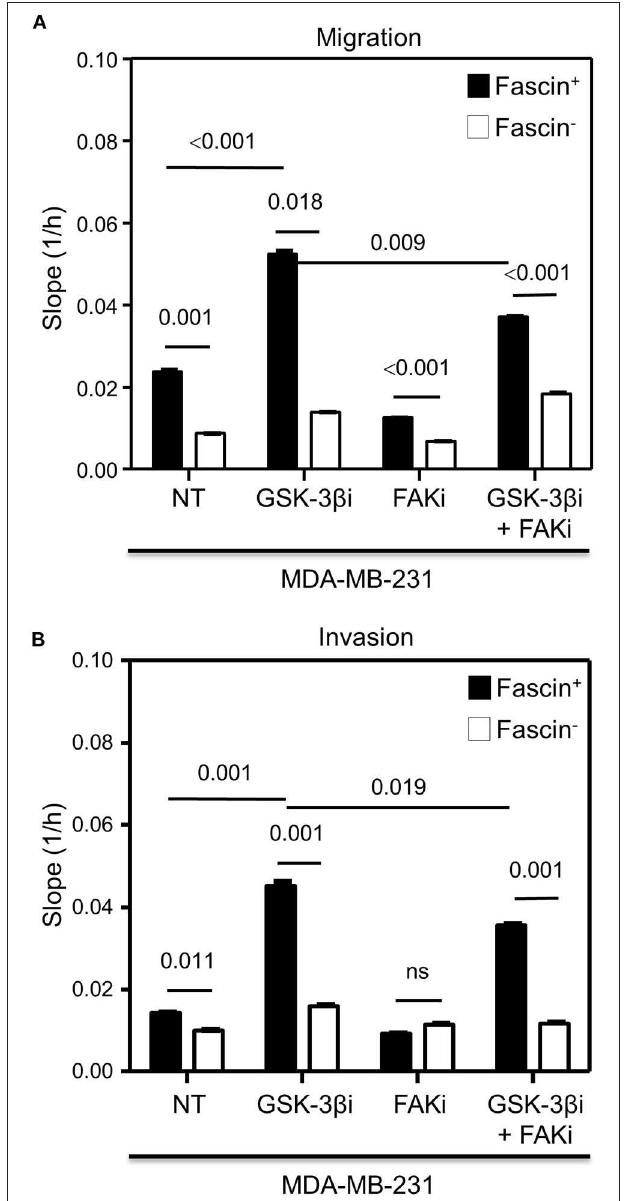
FIGURE 5 | (A,B) Fascin activation of β -catenin signaling pathway increases migration and invasion in a FAK-dependent manner. The rate of migration and invasion was monitored in real time using the xCELLigence system. Bar graph showing the migration (A) or invasion (B) rate of fascin + and fascin − MDA-MB-231 cells before and after treatment with GSK-3 β i ± FAKi. Migration and invasion rates were measured as increases in the slope (1/h) of the curve during 24h and are mean of triplicates ± SD of three independent